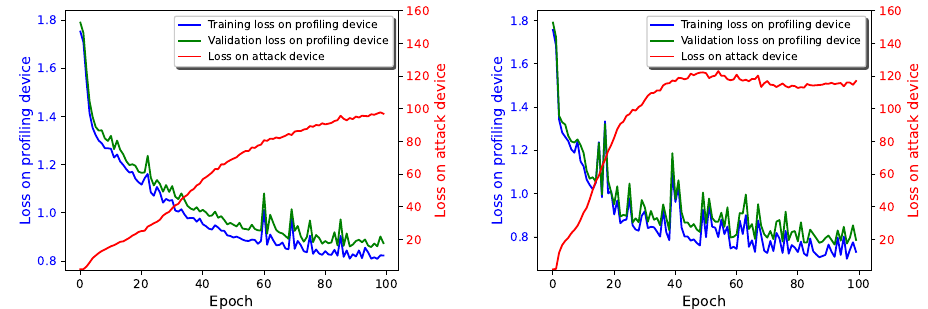
(a) CNN with 1 conv. block (8 filters, ks=50) (b) CNN with 1 conv. block (8 filters, ks=50) and 1 fully-connected layer (20 neurons). and 3 fully-connected layers (20 neurons). Figure 17: Learning curves for two different groups of CNN hyperparameters on the same dataset